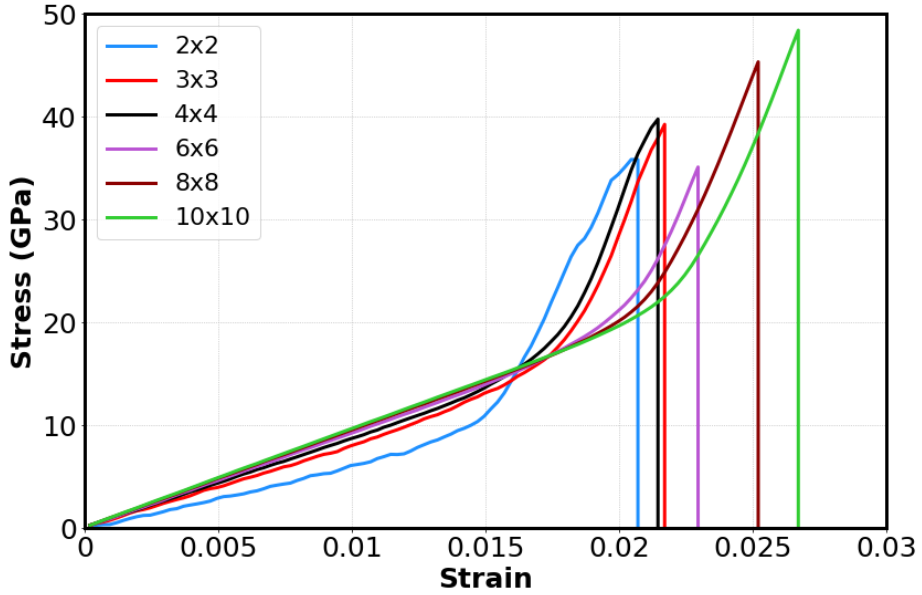
Figure 4. Size effects on stress-strain relationships under the condition of temperature T = 300 K,